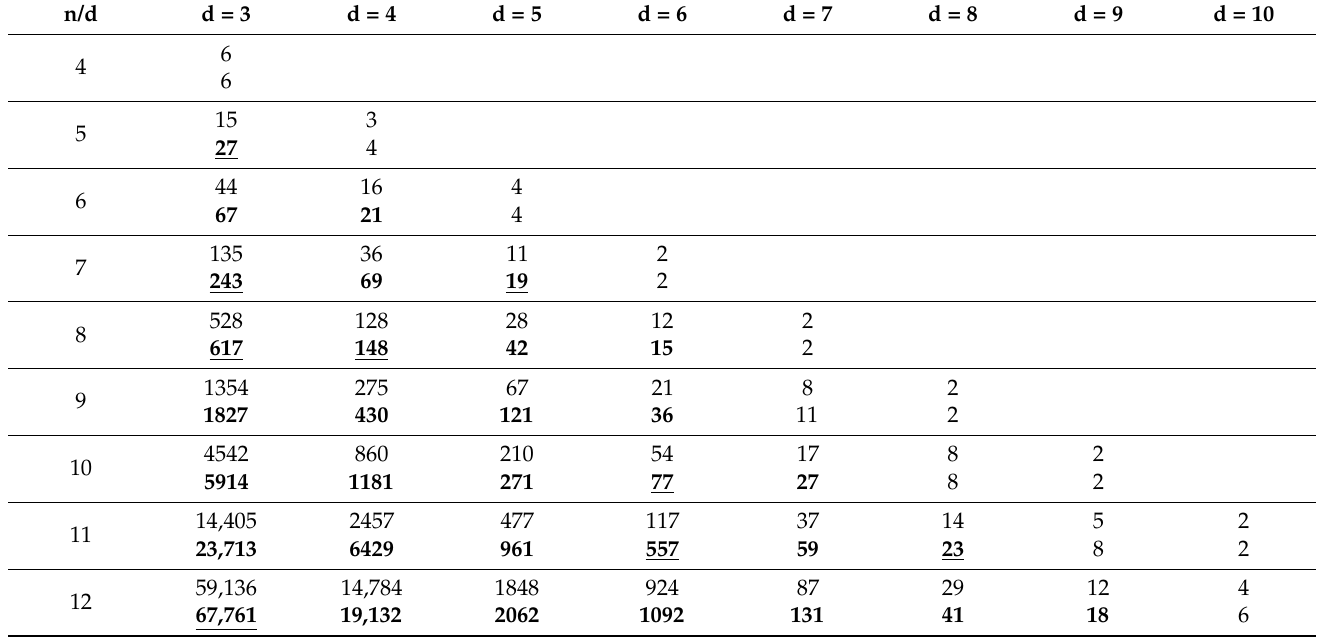
Figure 3. Lower bounds acquired by coding constraints with d H : ( a ) The CI mean with lower and upper bounds of coding constraints with GC for n = 8. ( b ) The coding rate comparison between lower bounds is obtained by RC for our work ( n = 8) and that of [20] n = 9. ( c ) The storage density with our DNA codes for n = 9 to n = 12 and d = 3 to d = 8. Table 3. Comparison of our lower bounds with [20] for A GC , RC 4